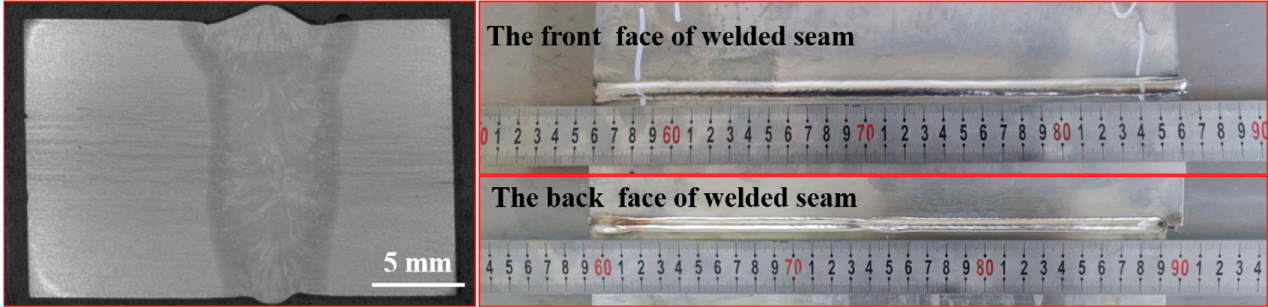
Figure 2. Macroscopic appearance of welded